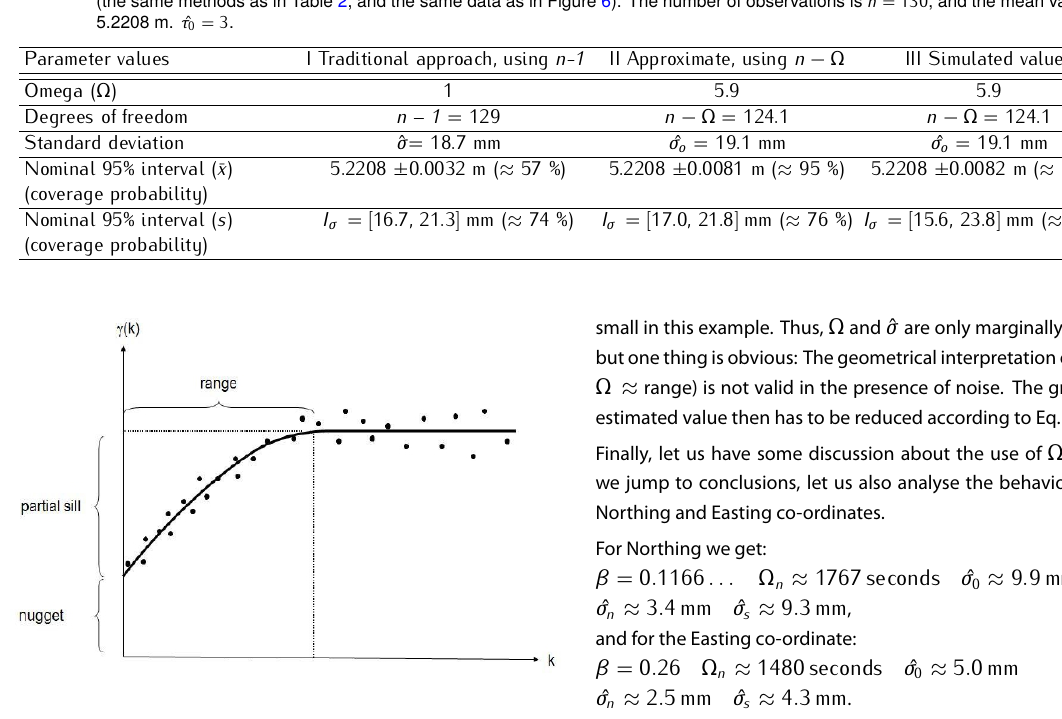
Figure 8. The sill is often composed of two parts: a discontinuity at the origin, denoted nugget , and the partial sill ; added together, these give the